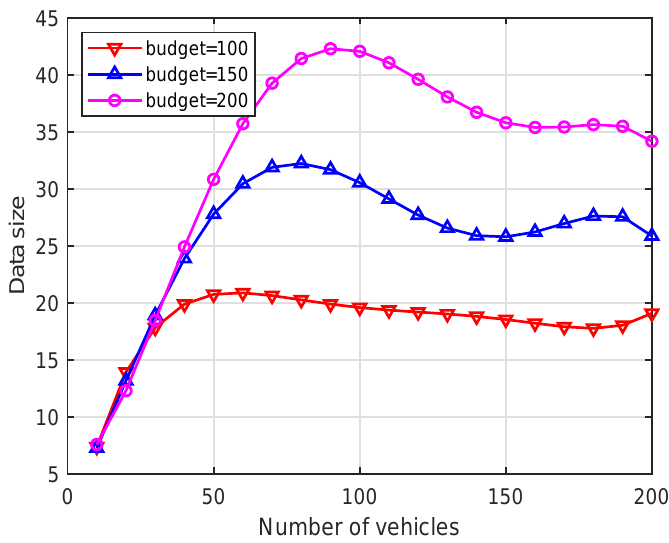
Figure 8. Vehicles vs. Data size.